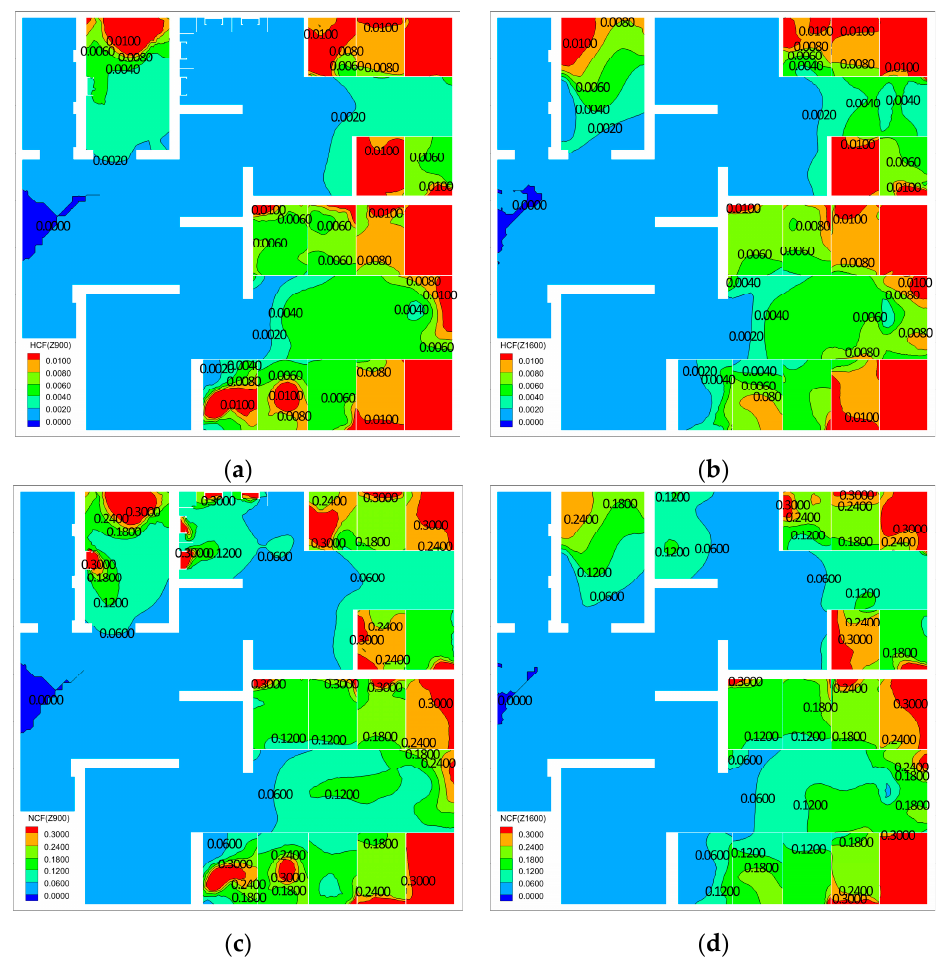
Figure 5. Concentration cloud map of pollutants in Scenario 3. ( a ) H 2 S concentration fraction (Z900); ( b ) H 2 S concentration fraction (Z1600); ( c ) NH 3 concentration fraction (Z900); ( d ) NH 3 concentration fraction